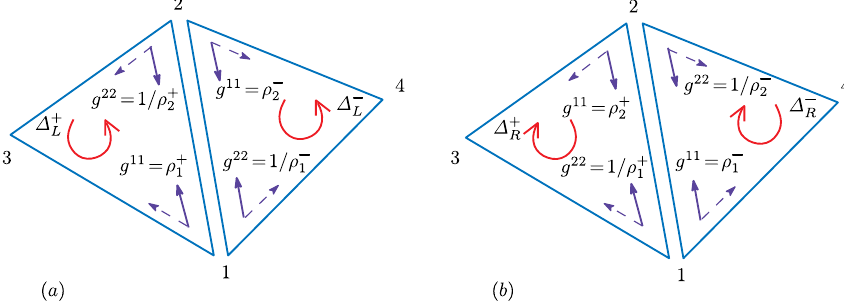
Figure 4. ( a ) Two neighboring triangles ∆ ± and ( b ) the inverted triangles ∆ ±